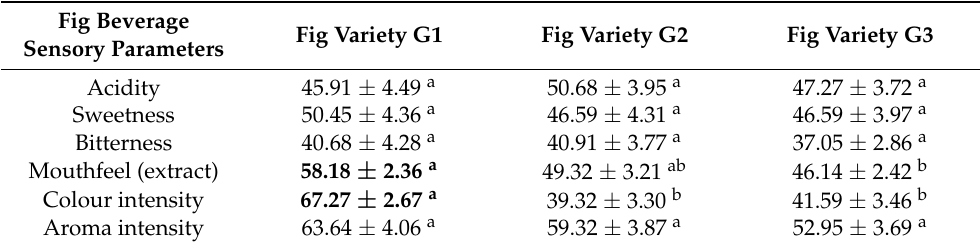
Table 3. General parameters assessed by sensory analysis for the fig fermented beverages on scales of 100 points (average ± standard errors).